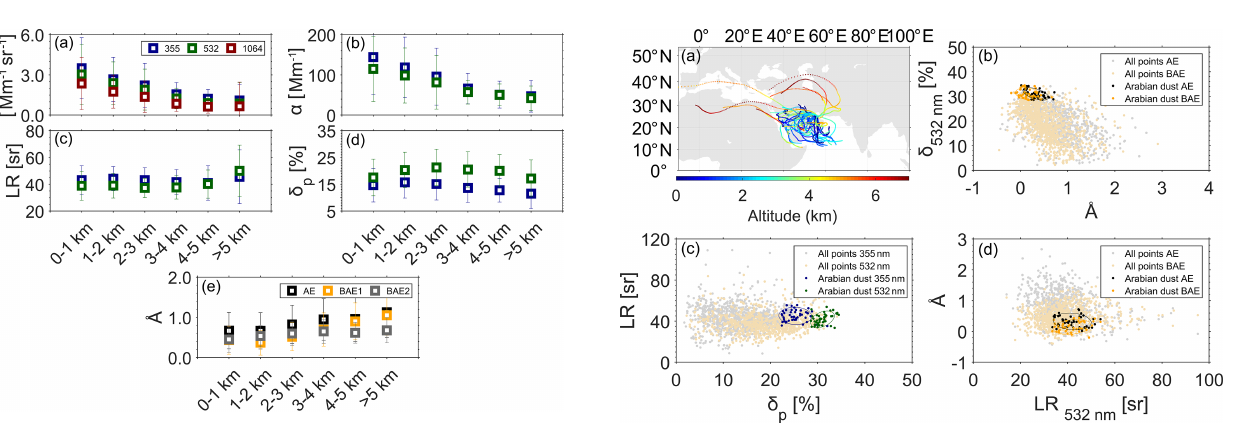
Figure 8. (a) Backward air mass trajectories of all the cases con- sidered for the characterization of the Arabian dust properties. (b) Ångström exponent (Å) versus linear particle depolarization ( δ p ) at 532nm. (c) Linear particle depolarization ( δ p ) versus lidar ratio (LR). (d) Lidar ratio (LR) at 532nm versus Ångström expo- nents (Å). The Ångström exponent plots at (b) and (d) indicate the extinction-related (AE) and backscatter-related (BAE) exponents at 355/532. The ellipsoids in panels (b) – (d) were drawn considering a 95% confidence for the set of data